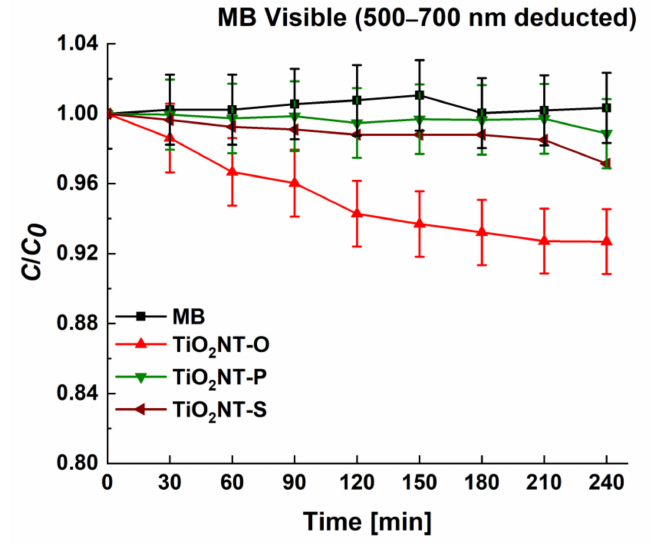
Figure 10. Assessment of dye sensitisation using a reduced spectrum.